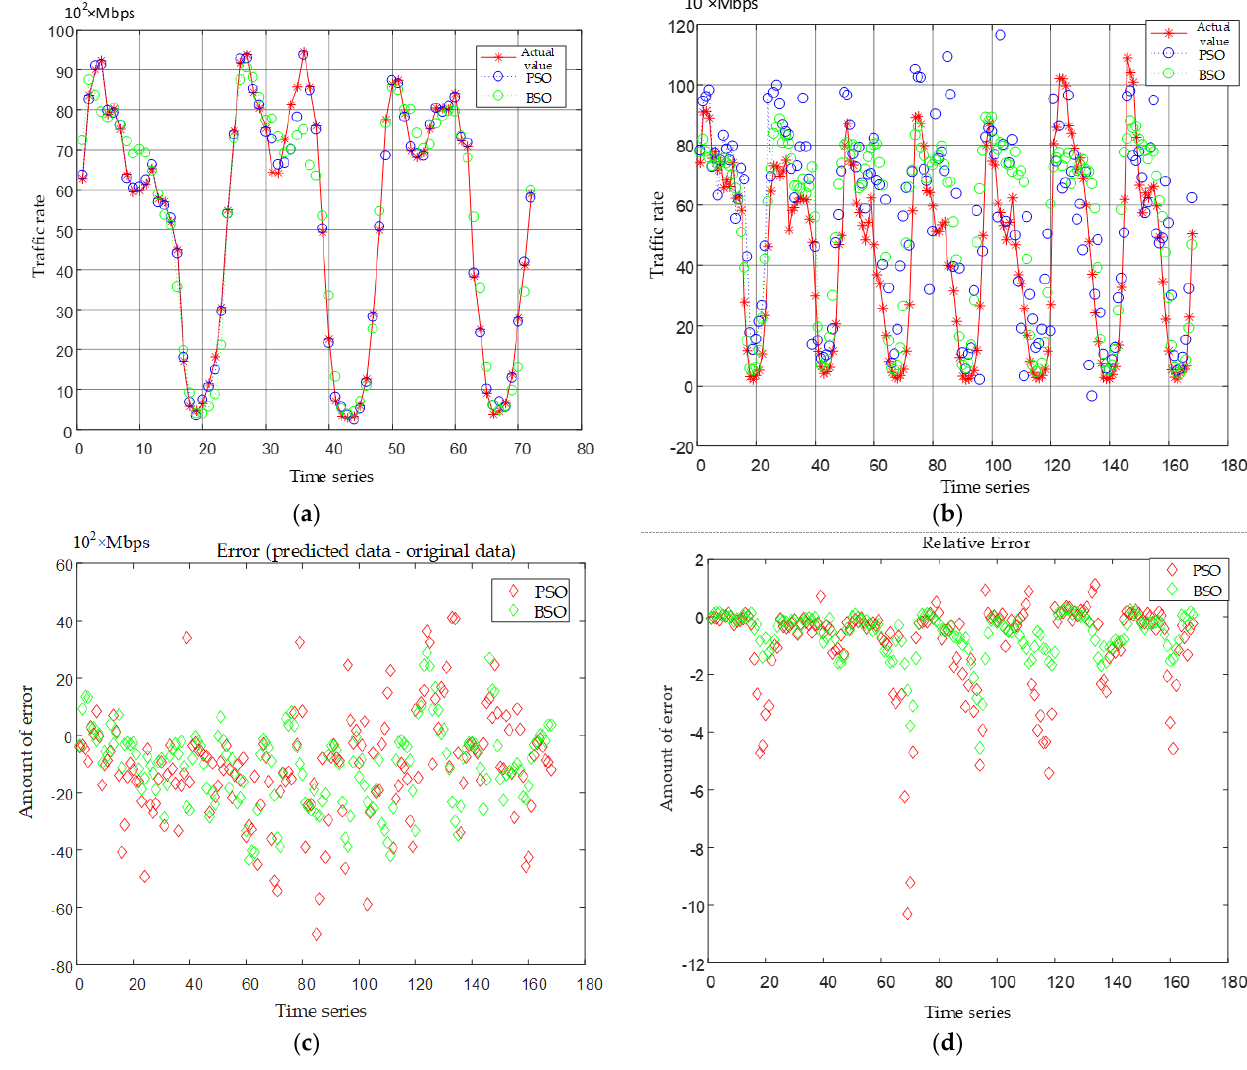
Figure 3. Comparison of forecasting effects with different methods. ( a ) Comparison of training results; ( b ) Comparison of predicting results; ( c ) Comparison of predicting error; ( d ) Comparison of relative error.